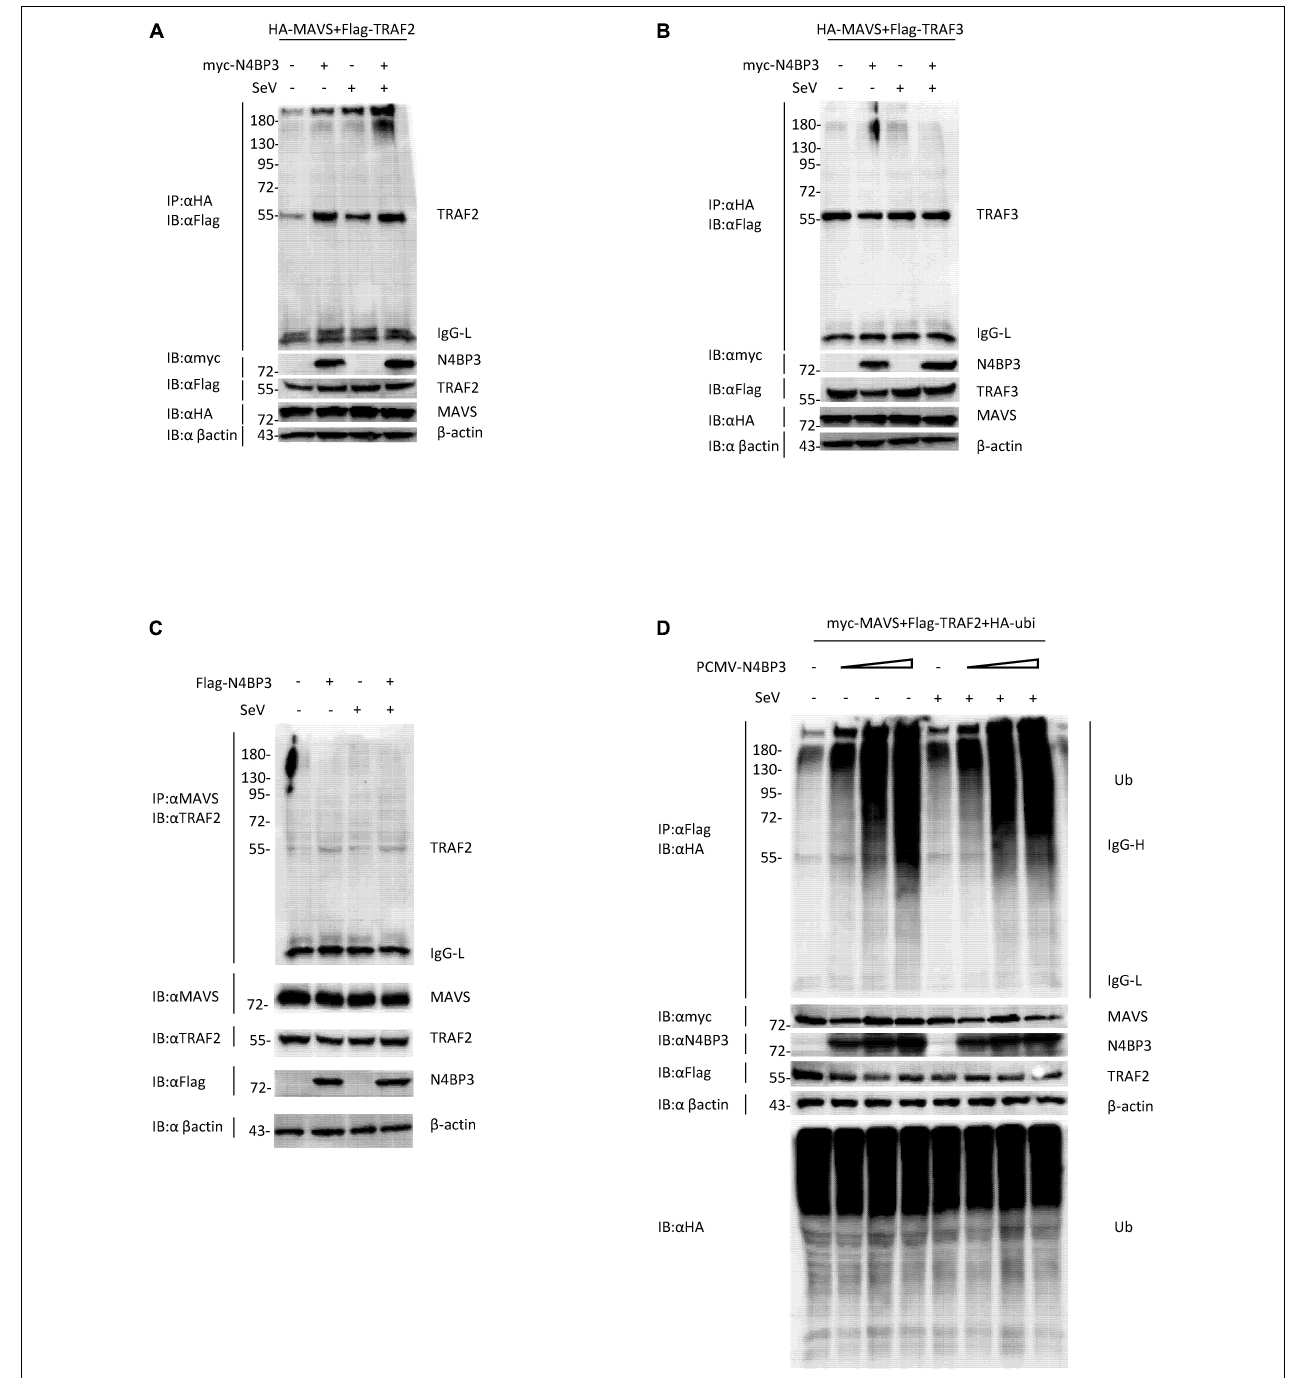
FIGURE 5 | N4BP3 strengthens the interaction between MAVS and TRAF2. (A) N4BP3 can promote the interaction between MAVS and TRAF2. Co-transfected HA-labeled MAVS, Flag-labeled TRAF2, and, respectively, transfected myc-labeled N4BP3 into 293T cells. After 12 h of transfection, the cells were left uninfected or infected with SeV for 12 h, and the cells were collected and lysed. The indicated antibodies were used for co-immunoprecipitation and immunoblotting analysis. Most lysates are used for anti-HA beads immunoprecipitation and western blotting analysis with anti-Flag antibodies. A small portion of the lysate is used for routine western blotting to check the expression of each plasmid. (B) N4BP3 does not affect the MAVS-TRAF3 complex. Co-immunoprecipitation and immunoblot analyses were similarly performed as in panel (A) . (C) N4BP3 promotes the interaction between endogenous MAVS and TRAF2. 293T transfected with the indicated plasmids. Coimmunoprecipitation and immunoblots were performed with the indicated antibodies. (D) N4BP3 can promote the polyubiquitination of TRAF2, a downstream complex of MAVS, and the effect of polyubiquitination is dose-dependent on N4BP3. 293T transfected with the indicated plasmids, followed by co-immunoprecipitation and immunoblotting analysis with the indicated antibodies.